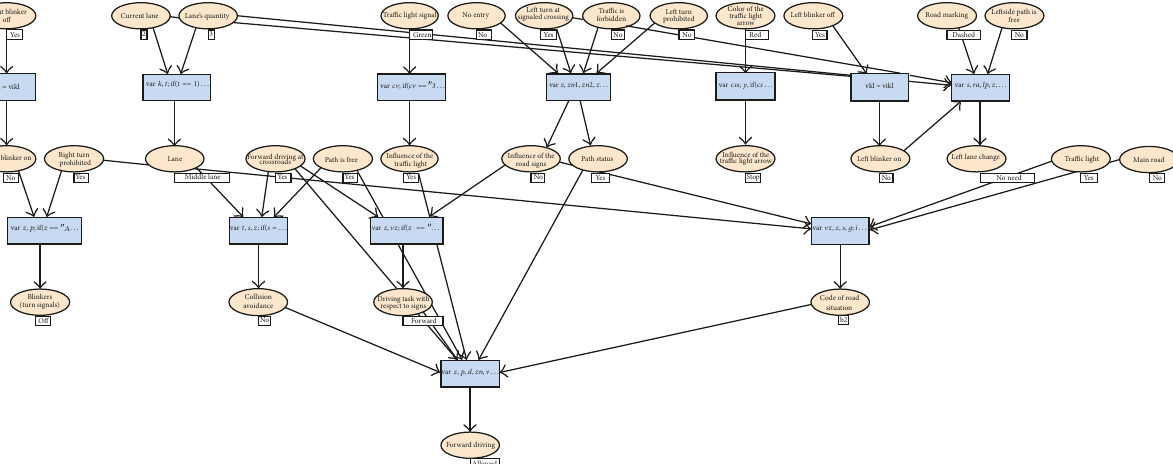
Figure 7: Example of a cognitive Mivar graph.